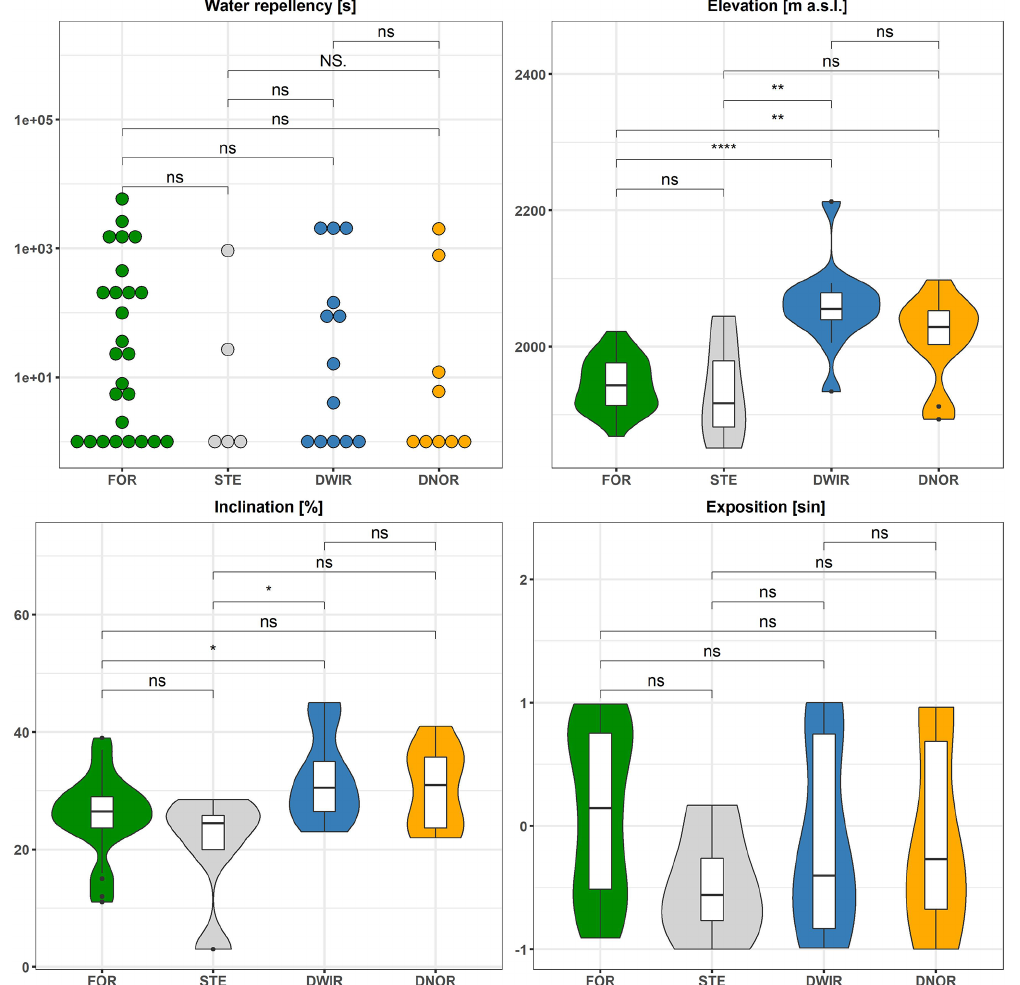
Figure A1. Scatterplots for water repellency (expressed as water drop infiltration time in seconds; n = 53) and violin plots and box plots for the elevation ( n = 54), inclination ( n = 54), and exposition ( n = 54) of the soils under the four vegetation categories of near-natural forest (FOR; green), steppe close to forest (STE; grey), disturbed forest with regrowth of trees (DWIR; blue), and disturbed forest showing no regrowth of trees (DNOR; orange). P values were calculated for differences between the arithmetic means (NS – p = 1; ns – p> 0 . 05; ∗ : p ≤ 0 . 05; ∗∗ – p ≤ 0 . 01; ∗∗∗ – p ≤ 0 . 001; ∗∗∗∗ – p ≤ 0 . 0001). Horizontal bars are medians, boxes are first and third quartiles, points are outliers, and violins are data